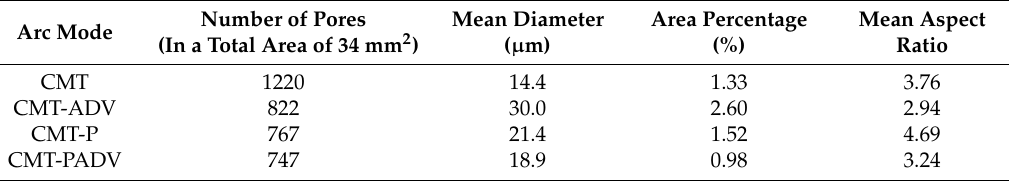
Table 3. Analysis results of pores for 2219 alloys fabricated in different arc